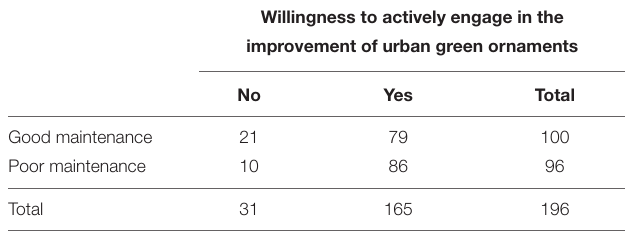
TABLE 1 | Contingency table reporting Yes or No responses to the scenario proposing the administrative